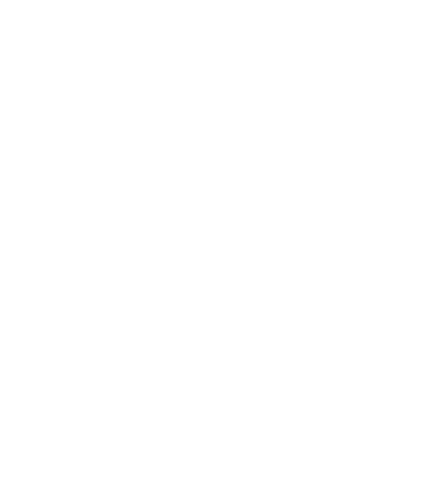
Fig 1. Flow chart of eligible studies selection during meta-analysis.